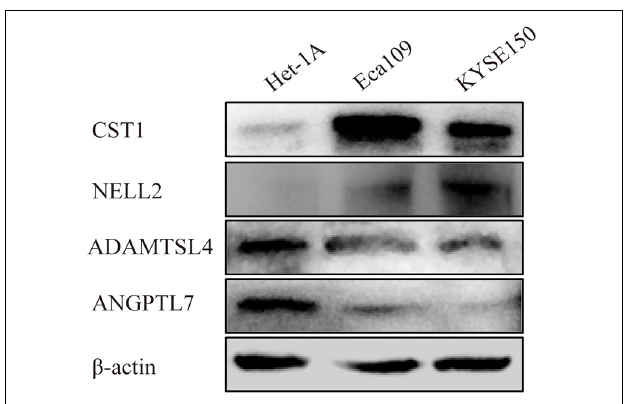
FIGURE 9 | Different expression levels of CST1, NELL2, ADAMTSL4, and ANGPTL7 proteins in the ESCC cell lines Eca109 and KYSE150 and the normal cell line Het-1A detected by western blotting.